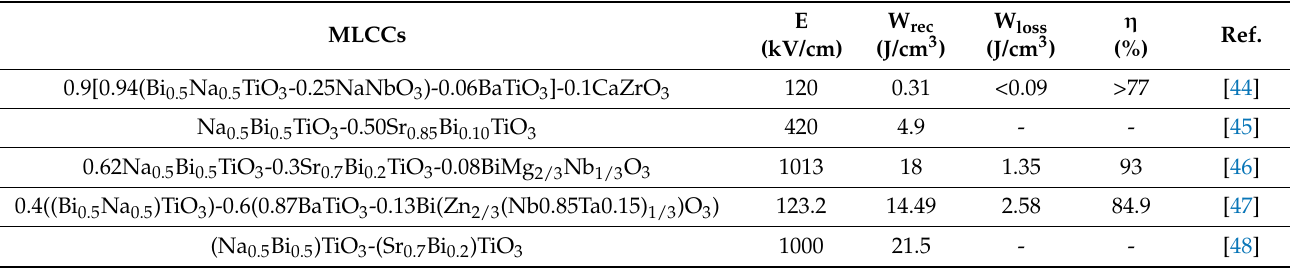
Table 4. ESP of BNT-based multilayer